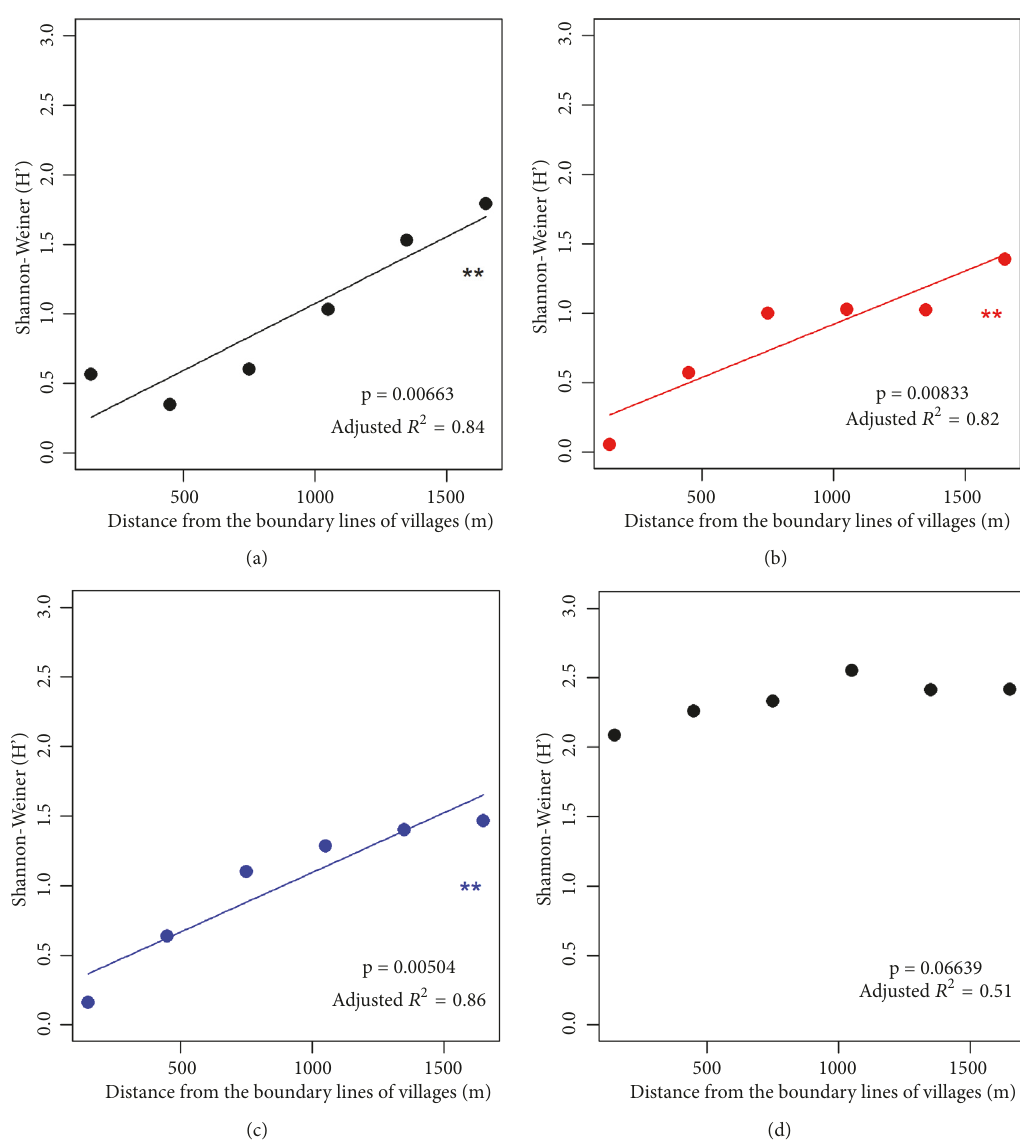
Figure 9: Shannon-Wiener H’ diversity index as a function of the distance from the village boundaries. (a) Janajagaran Forest: significant (p < 0.01), (b) Musharni Mai Forest: significant (p < 0.01), (c) Radha Krishna Forest: significant (p < 0.01), and (d) Parsa Wildlife Reserve: nonsignificant (p > 0.05).